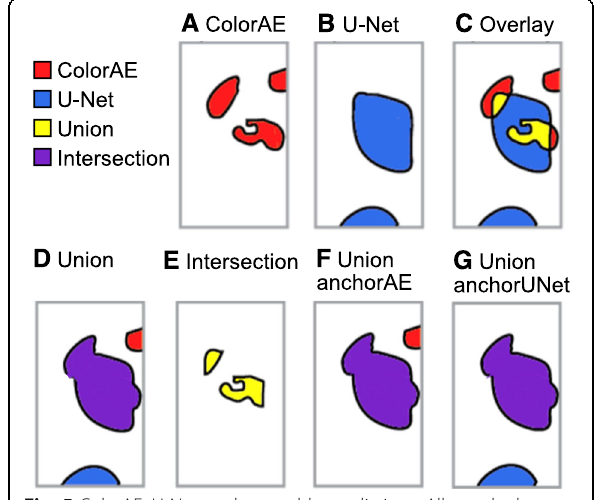
Fig. 5 ColorAE, U-Net, and ensemble predictions. All panels show predictions from the same cell class from the same input image. Top panel : A - C . ColorAE and U-Net predictions are shown for a single cell class are shown individually and overlaid. Bottom panel , ensemble methods : D . Union includes predictions from both ColorAE (red) and U-NET (blue): any overlapping predictions (detected by both algorithms) are merged into a single mask (purple). E . Intersection includes the pixels detected by both algorithms, while excluding any areas of the mask detected by only one algorithm. F . UnionanchorAE includes all masks detected by ColorAE and U-Net masks that intersect a ColorAE mask (union) while excluding U-Net masks that do not intersect a ColorAE mask (only detected by U-Net). G . UnionanchorUNet includes all masks detected by U-Net and ColorAE masks that intersect a U-Net mask (union) while excluding ColorAE masks that do not intersect a U-Net mask (only detected by